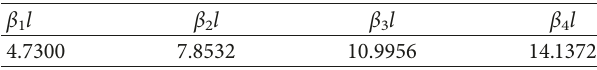
Table 4: The values of β i l for the clamped-clamped